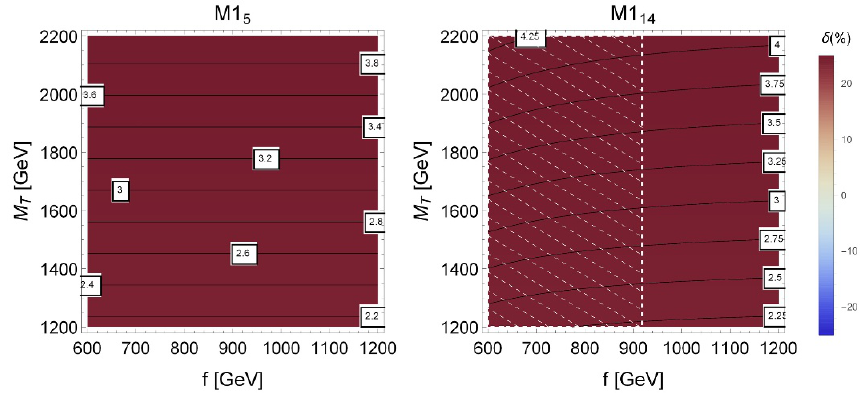
Figure 9 . The contour plots of (cid:14) ( p cut ) with sin 2 (cid:18) L = 0 : 1 and p cut = 600 GeV for each of the T T singlet models with one top partner multiplet. The corresponding values of y are indicated by the solid lines. The region marked by dashed white lines indicates when (cid:20) t (cid:20) 0 :